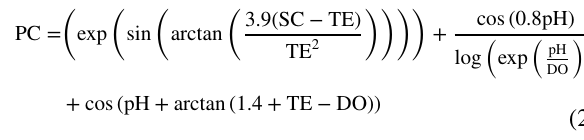
Table 7 Total number of parameters for the two ANFIS